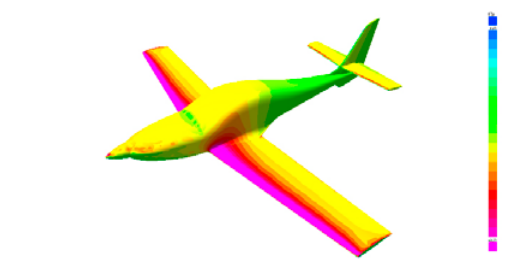
angleFig. Fig. 7. Cp distribution for a = 40deg and β = Fig. 8. Side force coefficient versus angle of attack Fig. 9. Side force coefficient versus sideslip